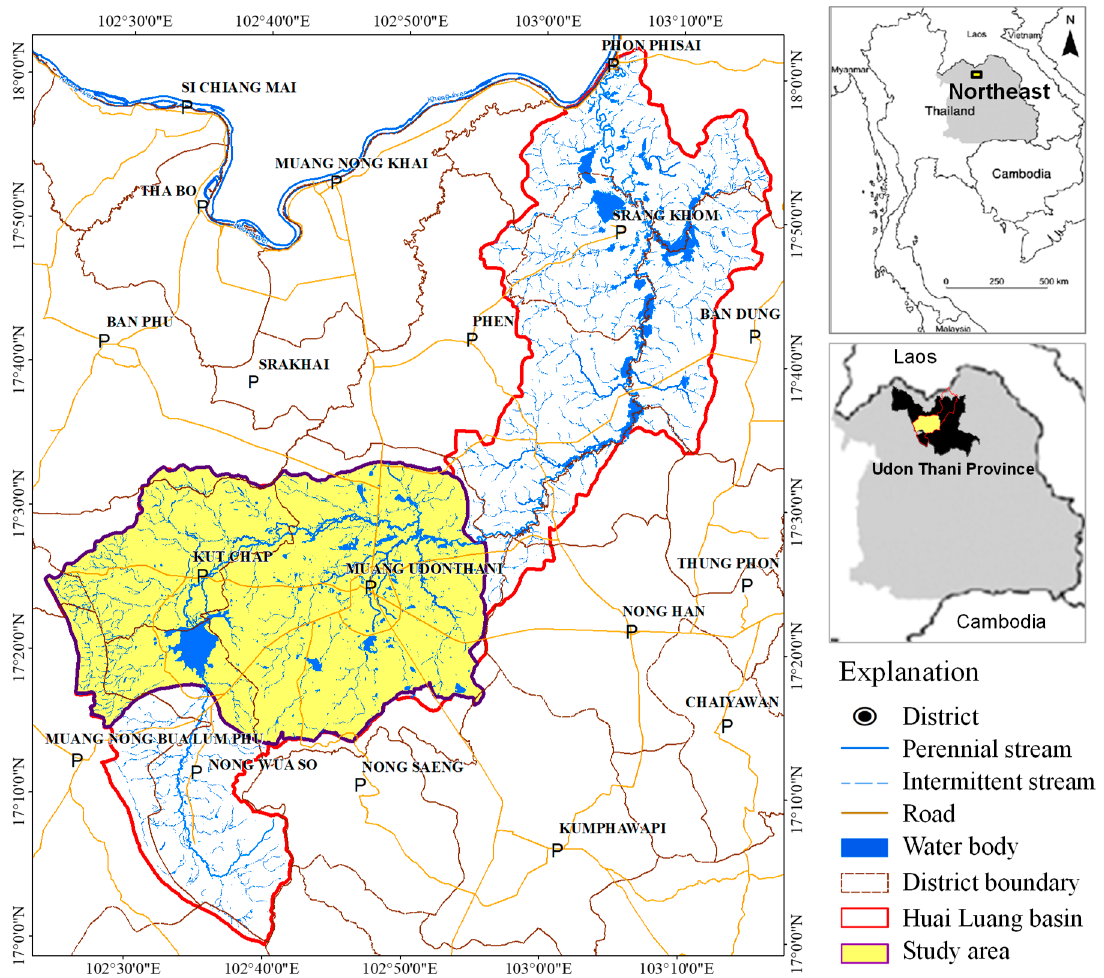
Figure 1. Location of the CHLB in the Huai Luang River Basin, NE Thailand .